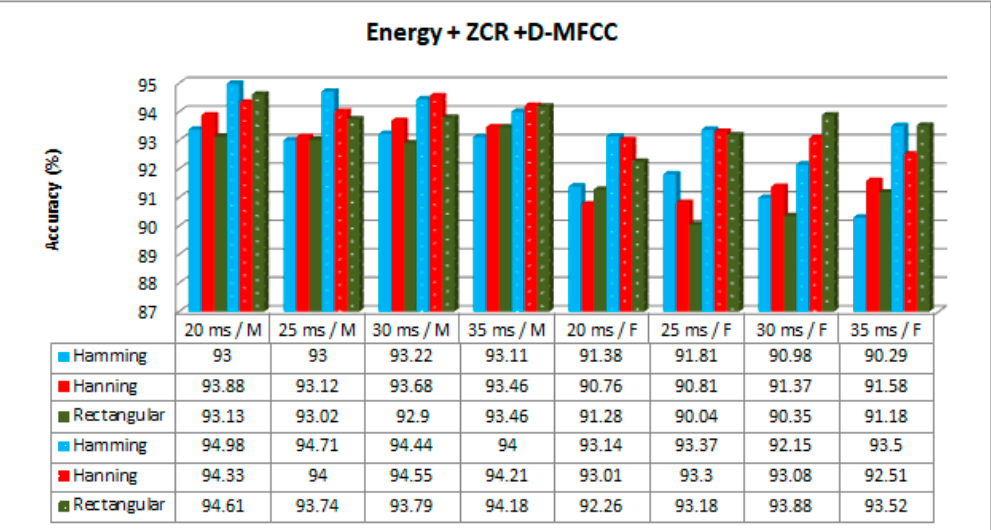
Figure 10. EZDMFCC accuracy results without GRU-based training (no dotted bars) and with GRU-based training (dotted bars) using a CNN classifier for male (M) and female (F) speakers.